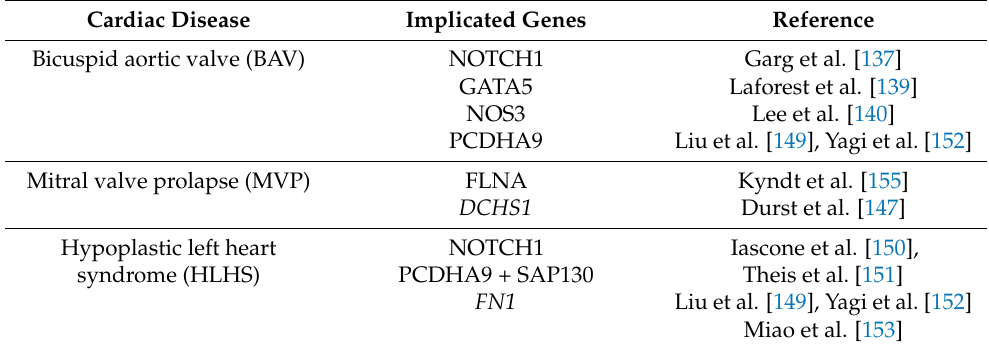
Table 1. Endocardial-related cardiac